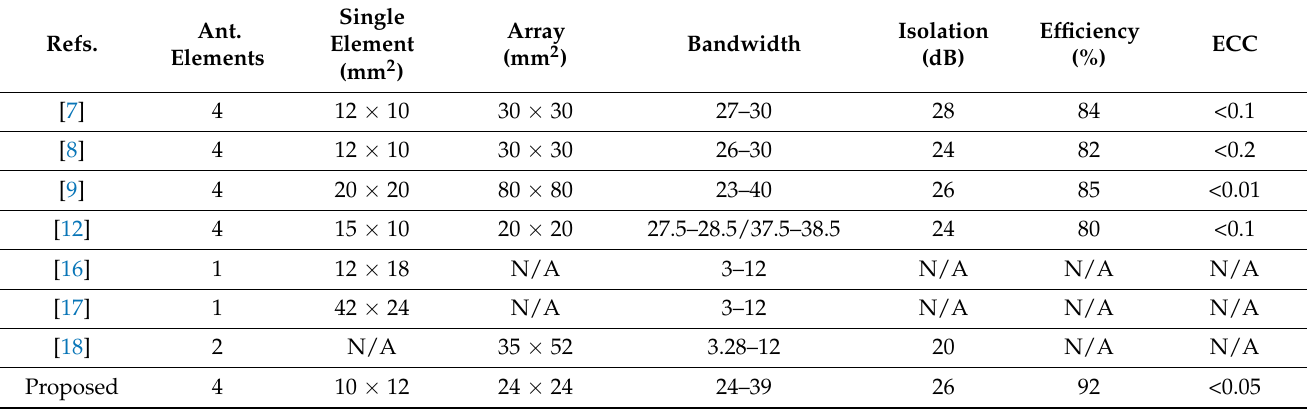
Table 2. Proposed Four-Element MIMO Antenna comparison with published literature.